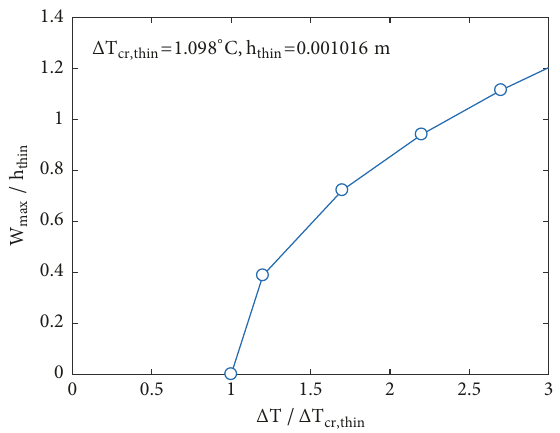
Figure 4: Thermal postbuckling response (a/h =